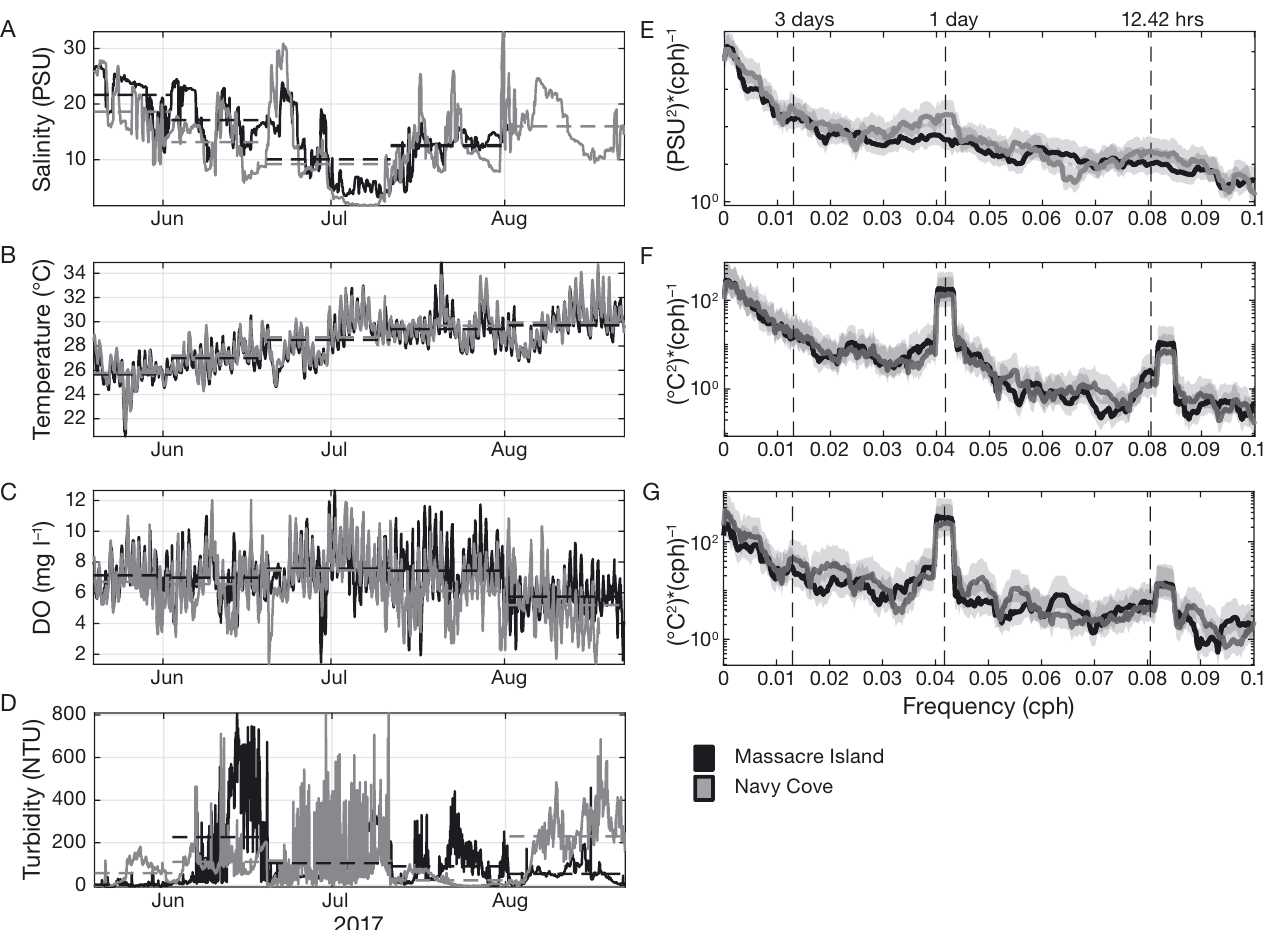
Fig. 4. (A−D) Hourly averaged time series and (E−G) the associated power spectral density of temperature, salinity, dissolved oxygen, and turbidity from short-term oyster deployment at Massacre Island and Navy Cove oyster farms. Sample collection period means are shown as horizontal dashed lines in (A−D). Gray shading in the power spectral density plots (E−G): 95% CI. cph: cycles per